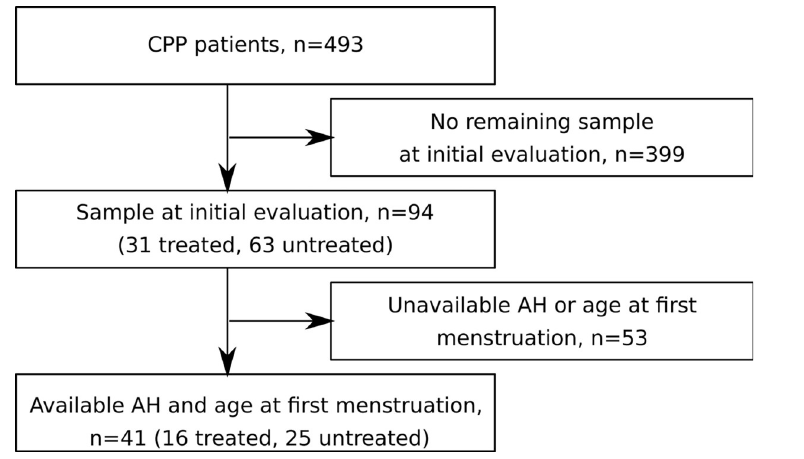
Fig 1. Flow chart of the inclusions of the girls with